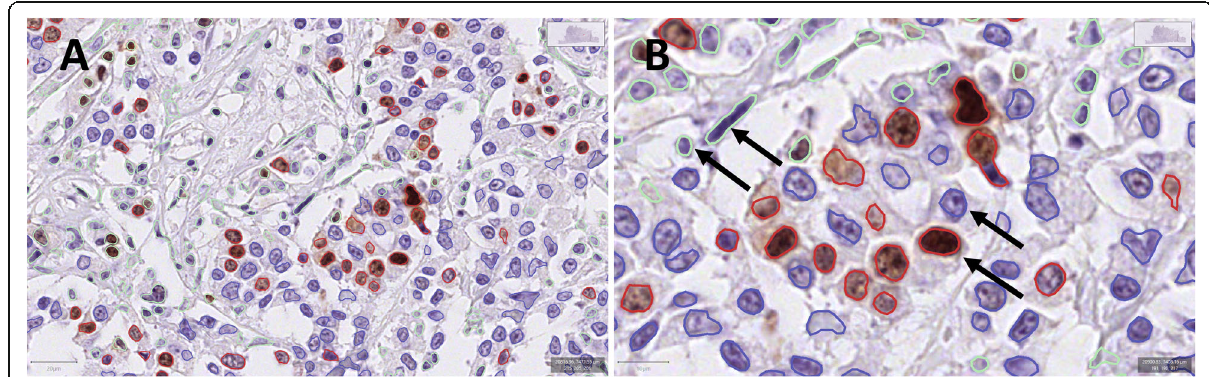
Fig. 2 A Overview image from QuPath showing cell nucleus detection and classification. B Arrows indicate elongated stromal nucleus and lymphocyte (green); Ki-67 positive tumour cell nucleus (red) and Ki-67 negative tumour cell nucleus (blue)